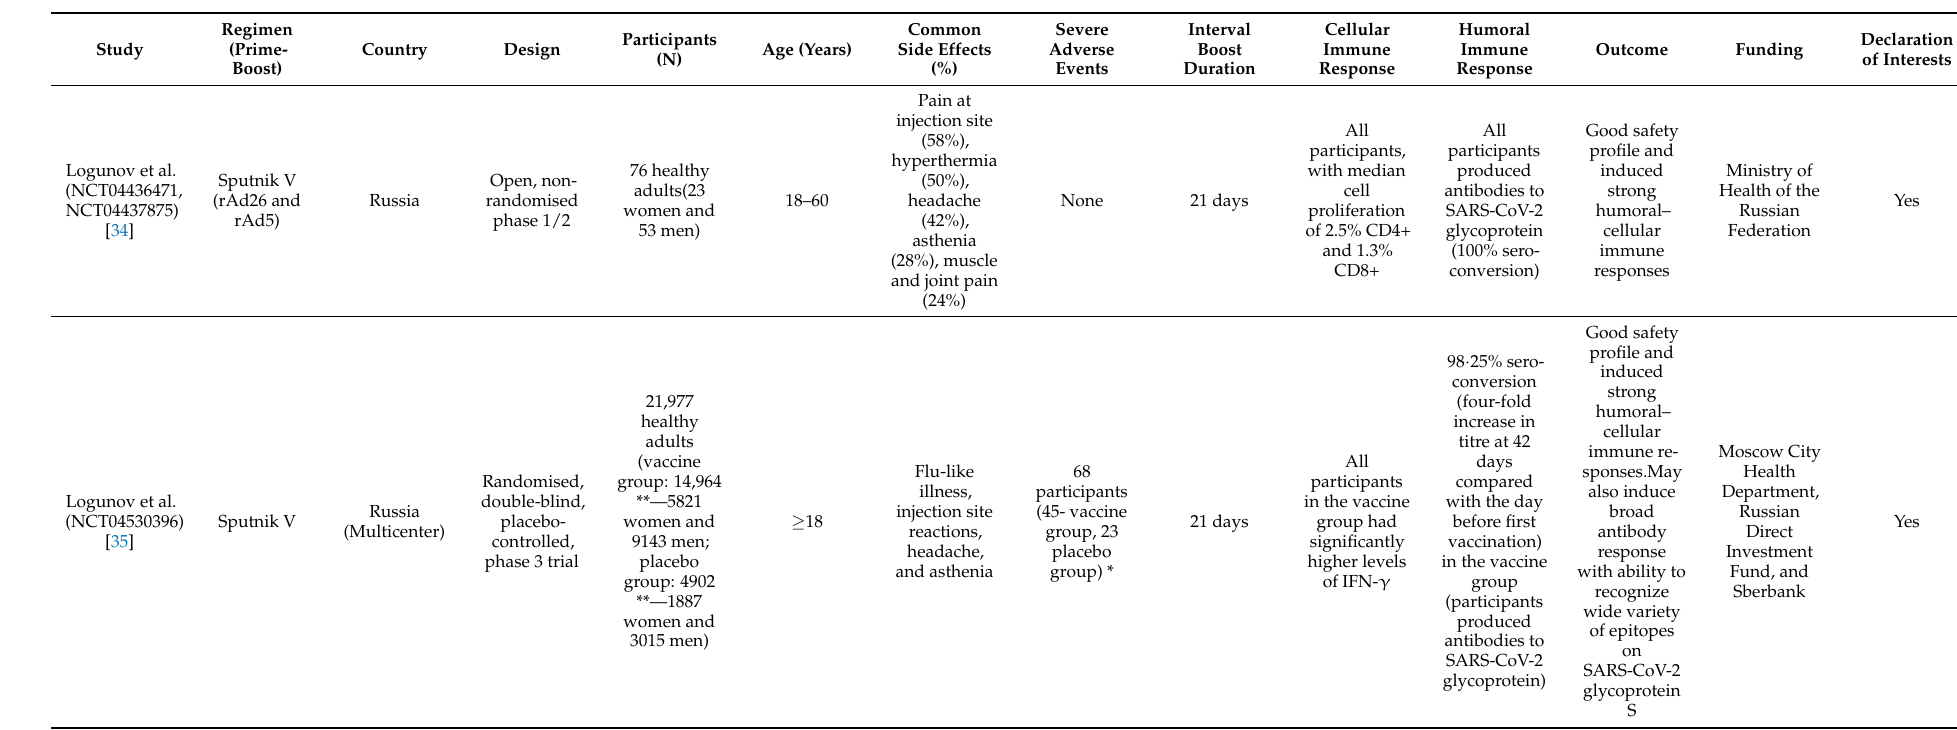
Table 1. Summary of included studies on heterologous COVID-19